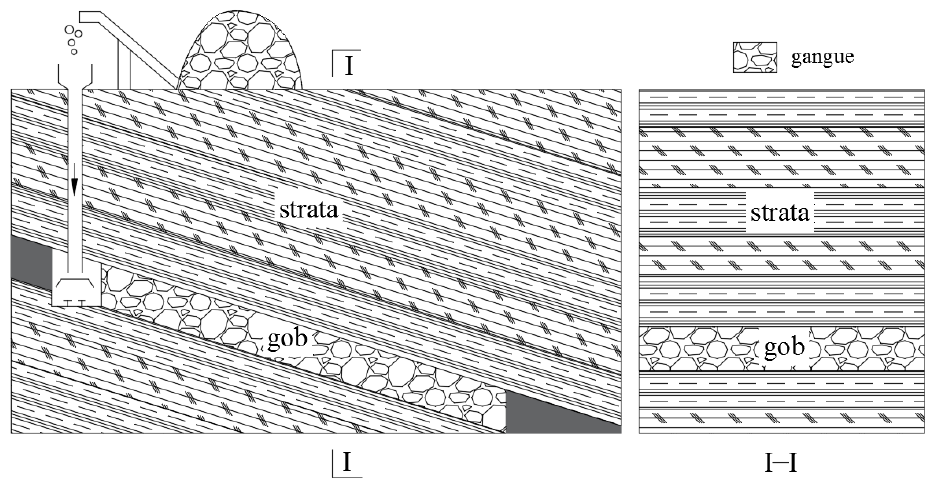
Figure 25. Gangue backfill mining system.